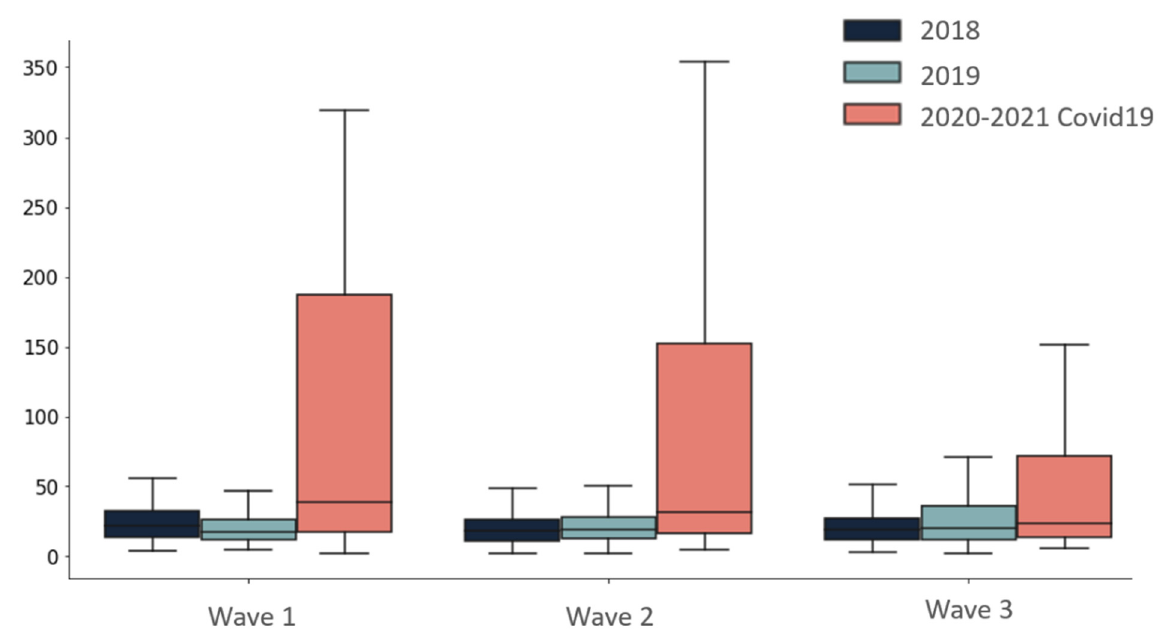
Figure 2. Time to first administration of antibiotics (in hours). p < 0.001 for the comparison of time to first administration of antibiotics in COVID-19 departments compared to equivalent departments in the same calendar months of 2018 and 2019.